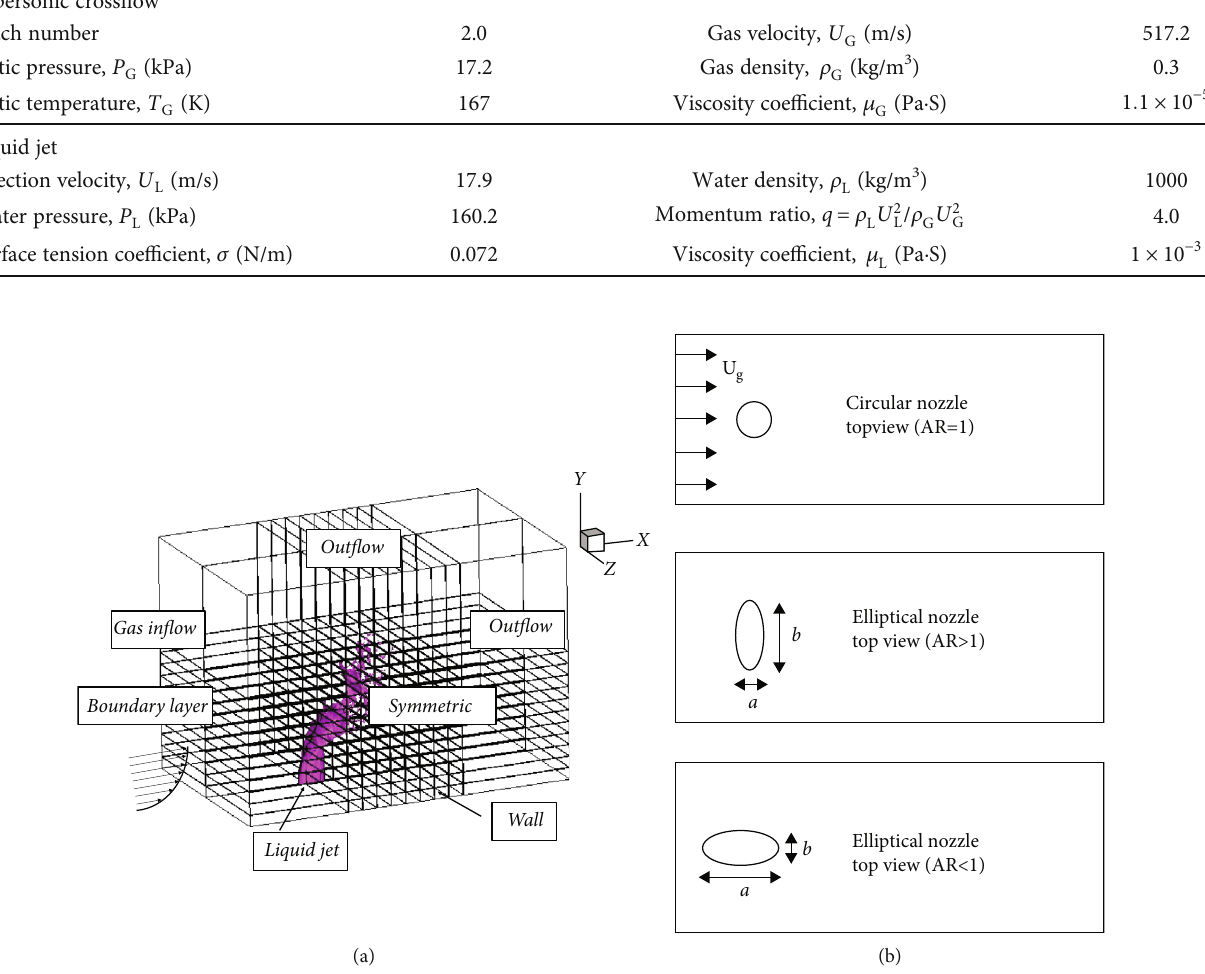
Figure 2: Simulation domain of elliptical liquid jet and top view of di ff erent ori fi ce